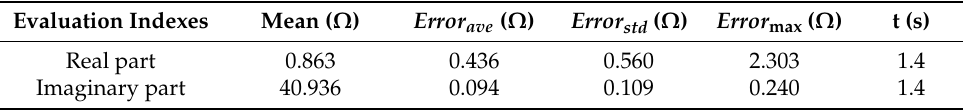
Table 8. Evaluation indexes of method 1 in 7th harmonic.